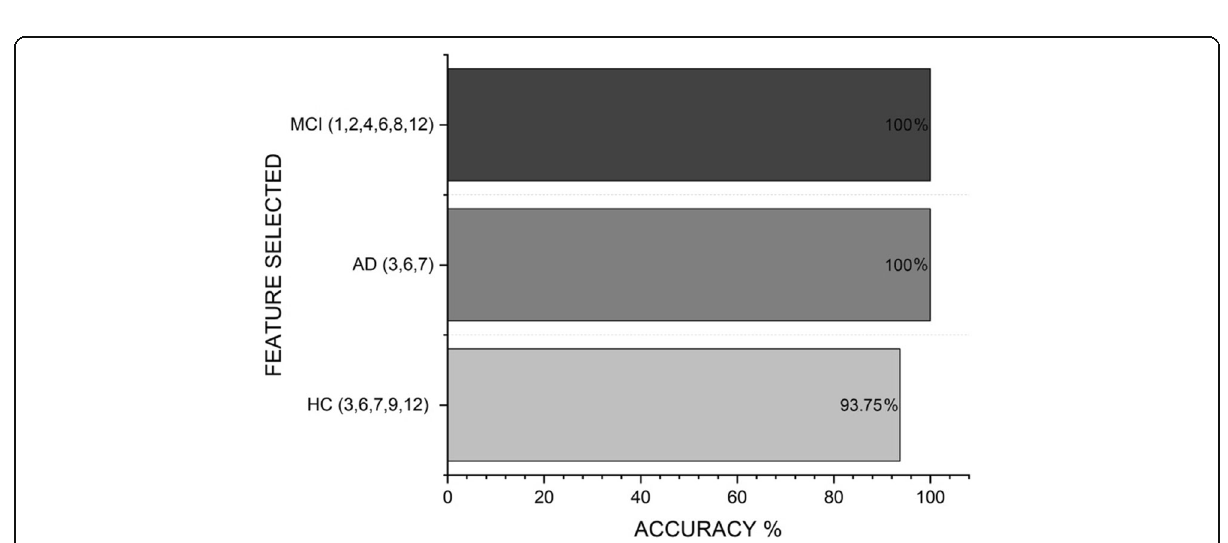
Fig. 2 Accuracy of different classes using SVM polynomial order